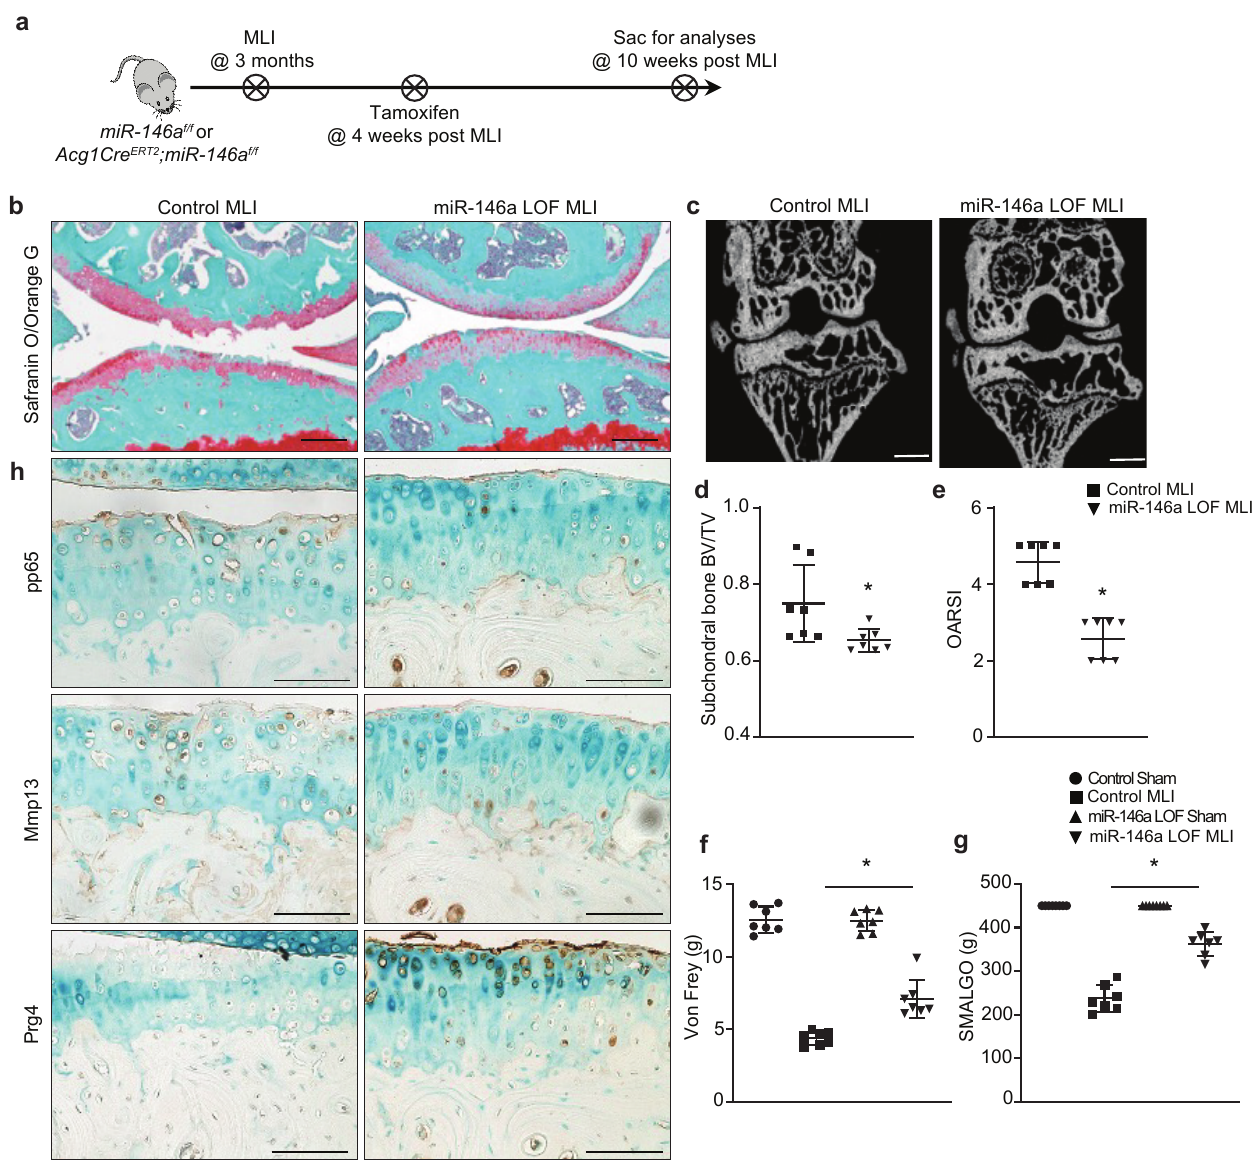
(Supplementary Figure S3), indicating that the upregulation of miR-146a under inflam- matory conditions and further activation of NF- κ B activity are partially responsible for development of more severe OA. Figure 4